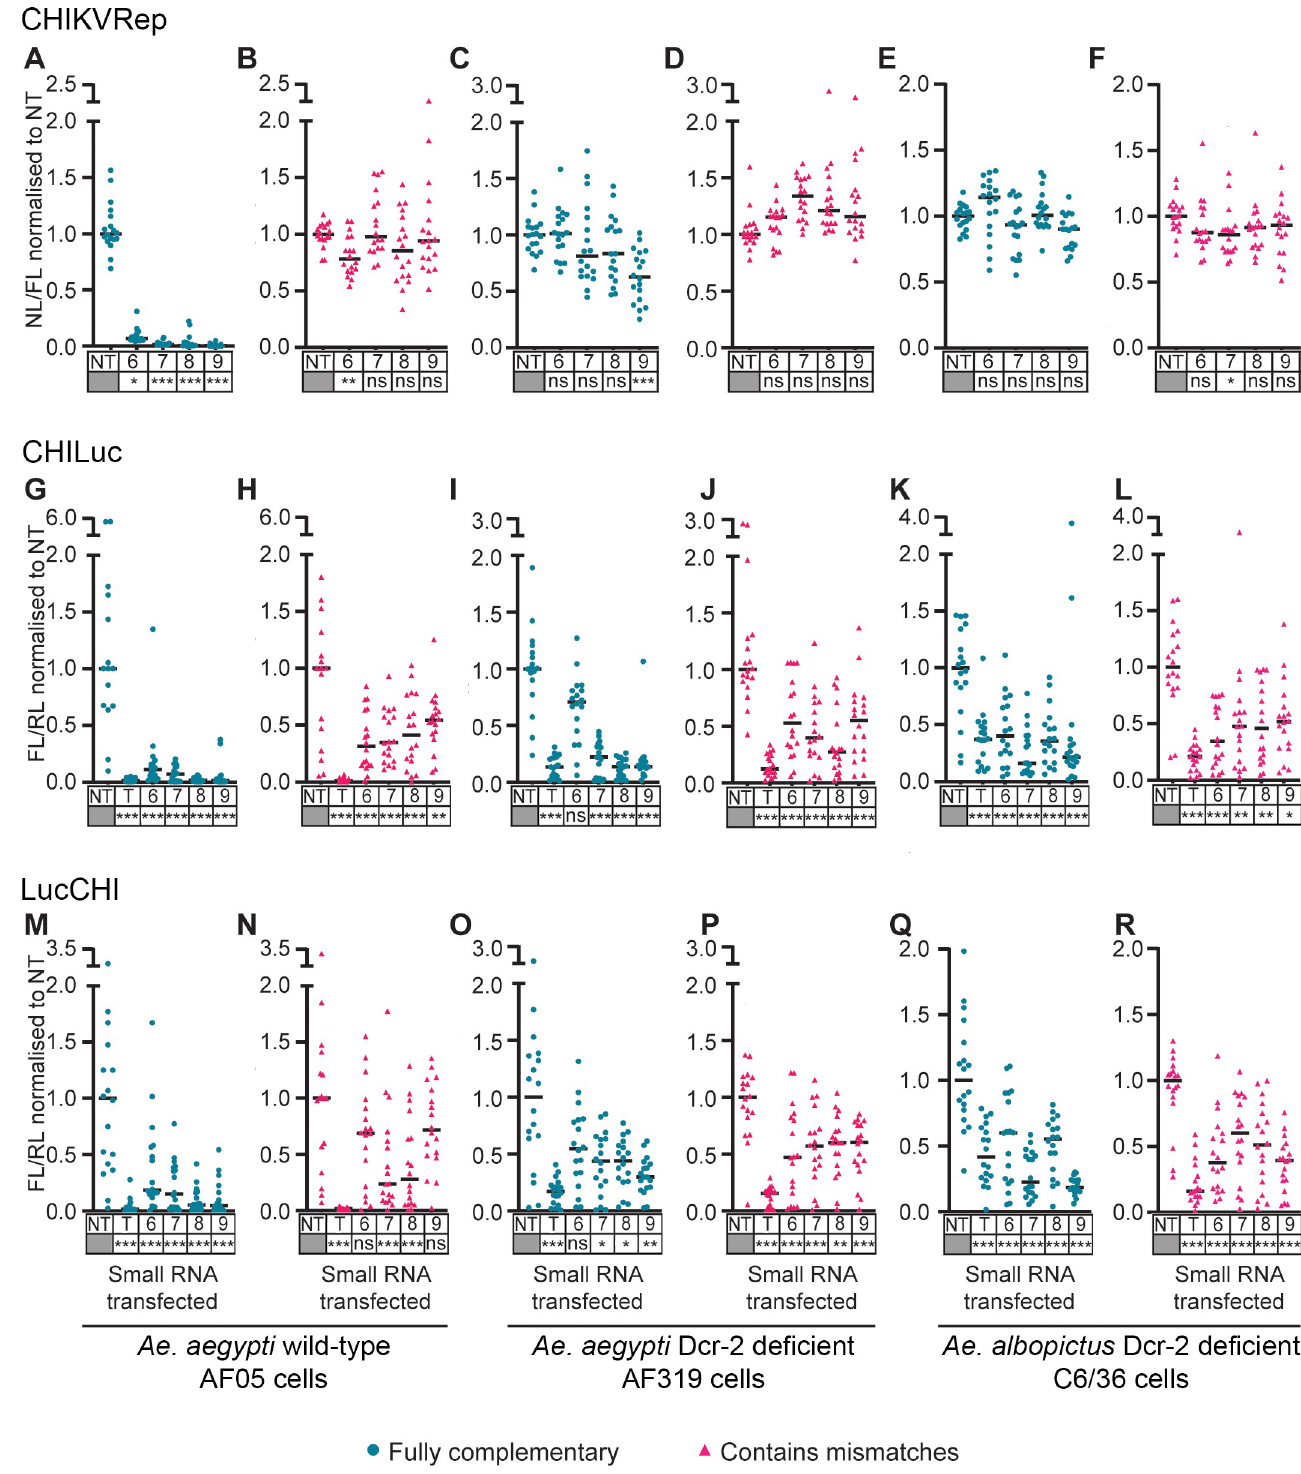
Fig 4. Effect of selected small RNAs on expression of a CHIKV split replication system and different reporter systems containing viral sequences in Ae . aegypti AF05 (A, B, G, H, M, N) cells, and Dcr-2 deficient Ae . aegypti AF319 (C, D, I, J, O, P) and Ae . albopictus C6/36 (E, F, K, L, Q, R) cells . Plasmids expressing selected shRNA-like small RNAs (Fully complementary, blue) or miRNA-like small RNAs (Contains mismatches, pink) were co-transfected with a split replication system with nanoluciferase (NL) under the control of a CHIKV subgenomic promoter, and a plasmid expressing firefly luciferase (FL) as control